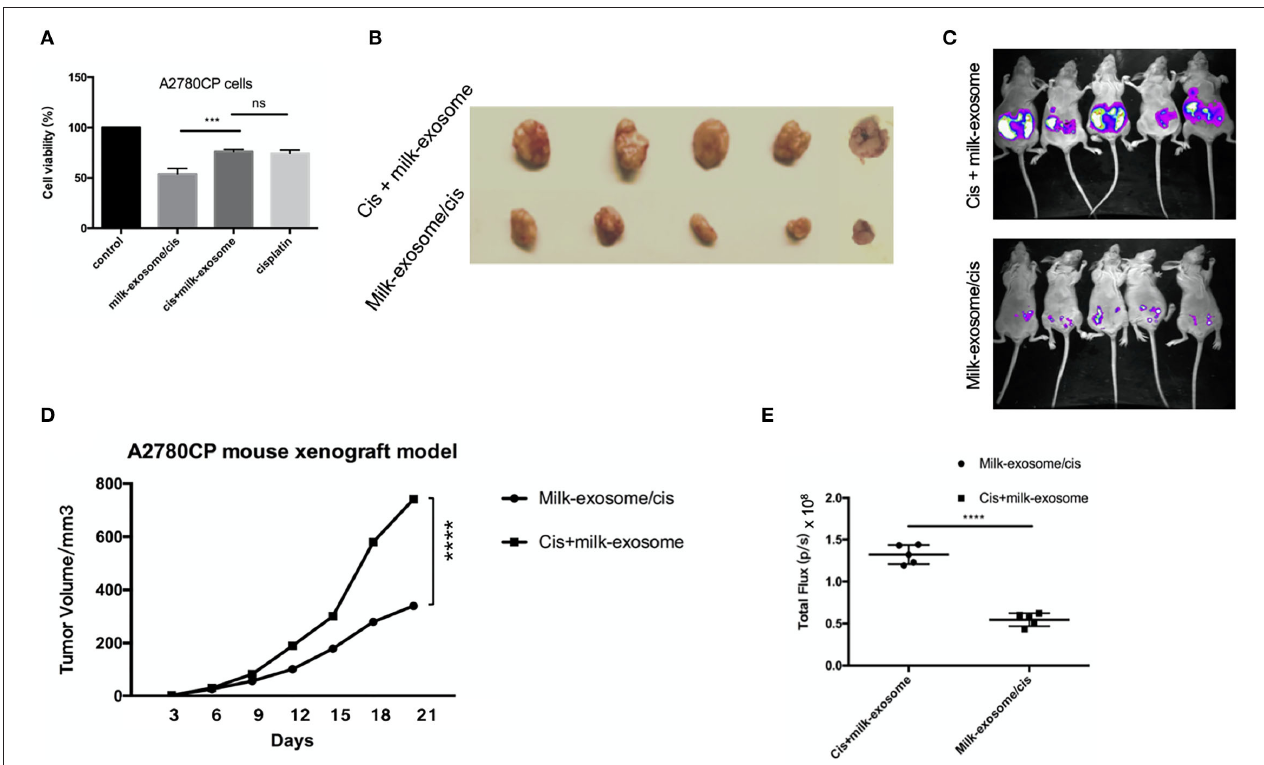
FIGURE 3 | Effect of milk-exosome loaded cisplatin on cisplatin-resistant ovarian cancer in vitro and in vivo . (A) The cisplatin-resistant ovarian cancer A2780CP cells were treated with cisplatin (5 µ g/mL), milk-exosome/cis (5 µ g exosomal cisplatin/mL), milk-exosome, and PBS. CCK8 assays were conducted after 24h. Three independent experiments with biological repeats. (B) Milk-exosome/cis enhanced the anti-cancer effect in vivo . Nude mice were subcutaneously injected with A2780CP cells. Mixture of cisplatin (4mg /kg b.wt.) with milk-exosomes, and milk-exosome/cis (4mg exosomal cisplatin/kg b.wt.) were injected every 3 days. Gross appearance of the tumors. (C) The size of the tumors was measured every 3 days. (D) Milk-exosome/cis enhanced the anti-cancer effect in bioluminescent ovarian cancer model in vivo . (E) Bioluminescent images were visualized and calculated. ****, P < 0.0001 and *** P < 0.001. ns, no